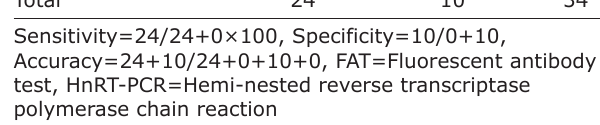
Brain FAT Total positive negative